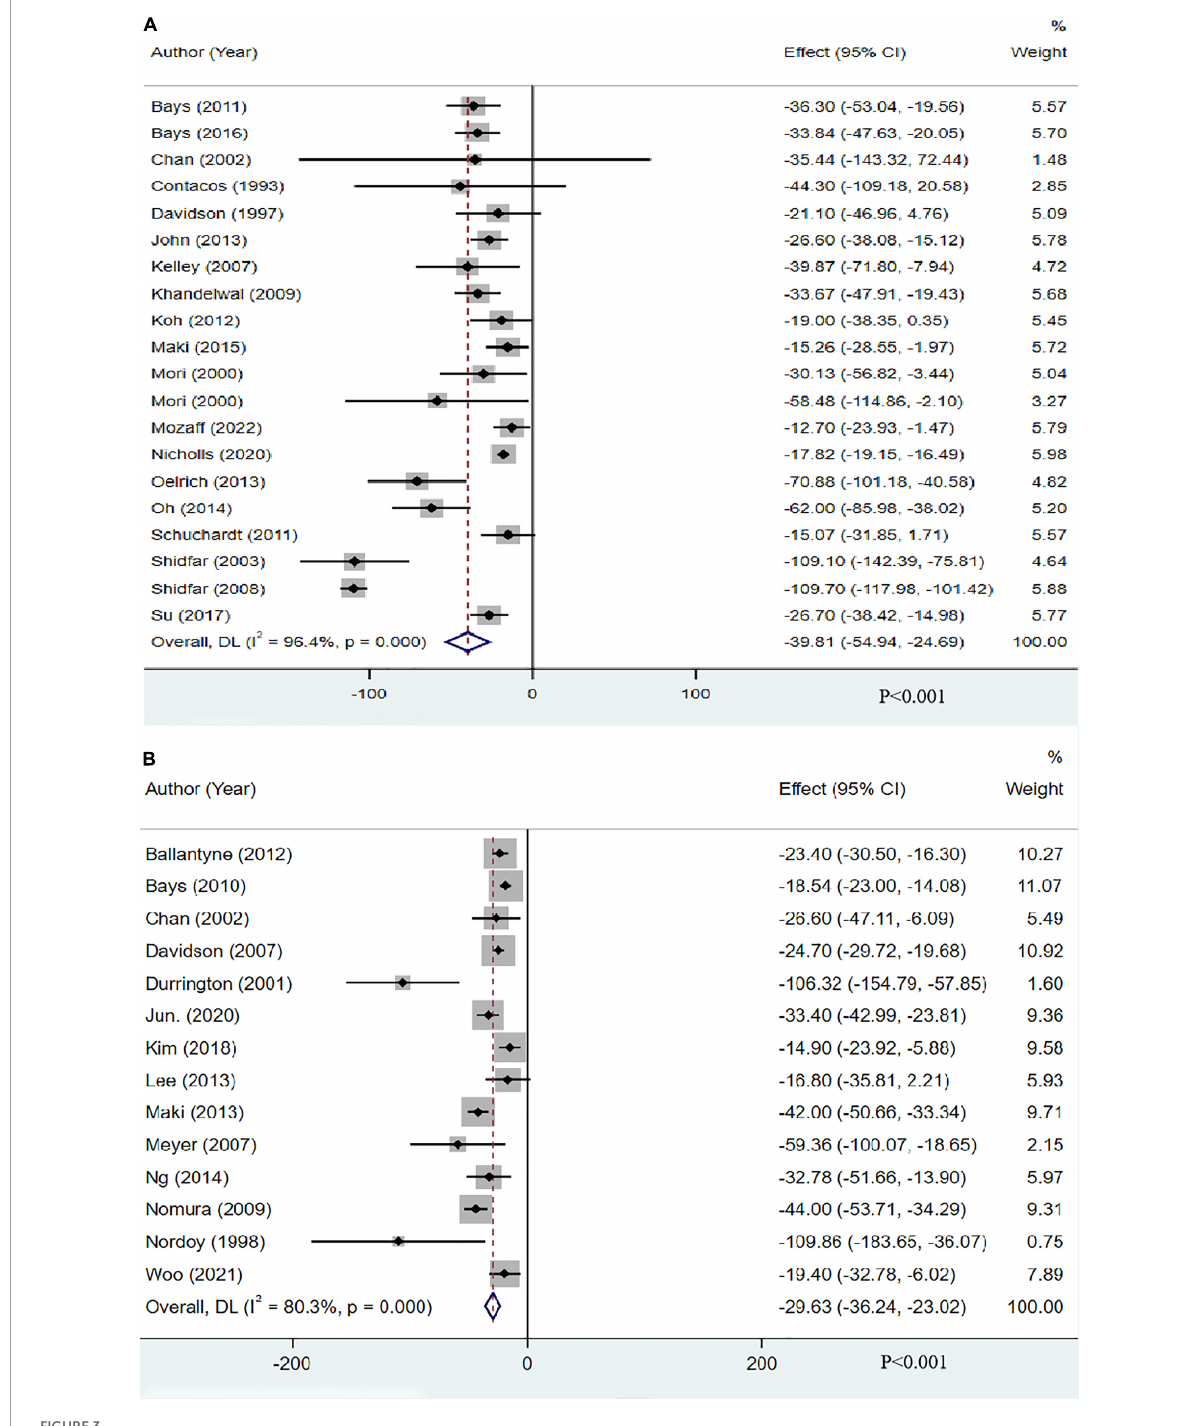
− 0.85, 95% CI: − 3.90 to 2.19, p = 0.58; I 2 = 49.3%, p had no significant effect on LDL-C if the participants had a he = 0.023), baseline TG level of < 200 mg/dL (MD: 3.81, 95% CI: − 4.80 which is quite different from the result when OM3-FA was used to 12.42, p = 0.39; I 2 = 38%, p he = 0.16) or ≥ 500 mg/dL alone ( Figure 6B ). In subgroup analyses, we found that OM3-FA